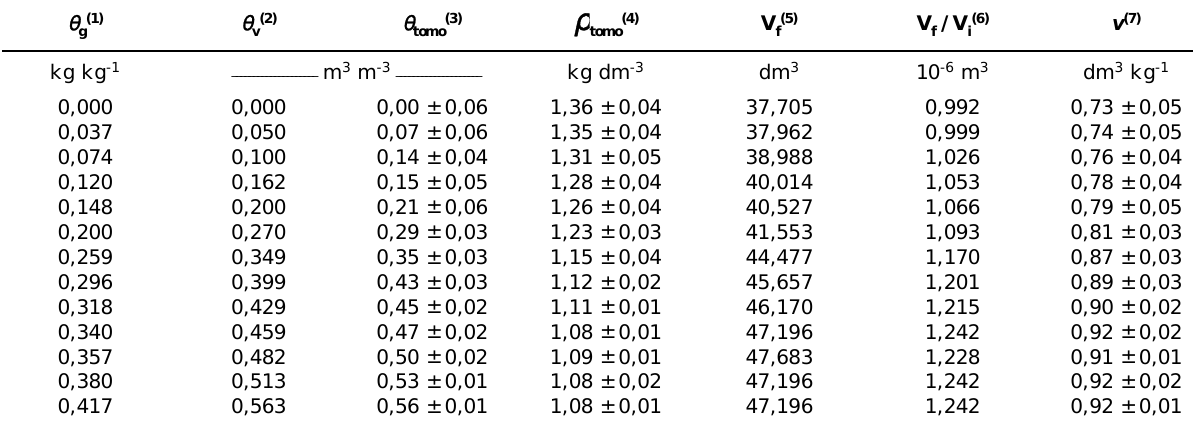
) e tomografia ( qqqqq g